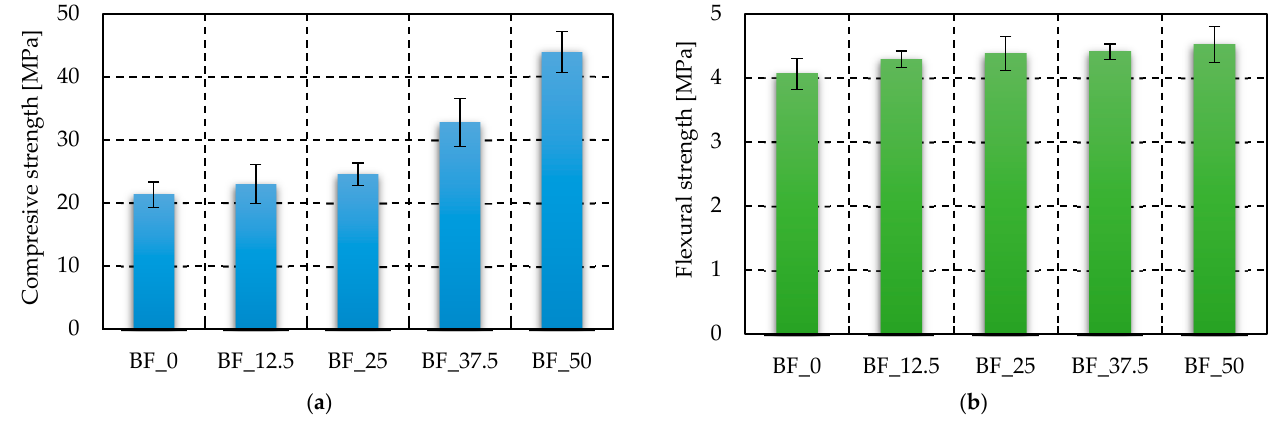
Figure 5. Results for tested geopolymers of ( a ) compressive strength test, ( b ) flexural strength. The obtained results of compressive strength are also higher in comparison with the